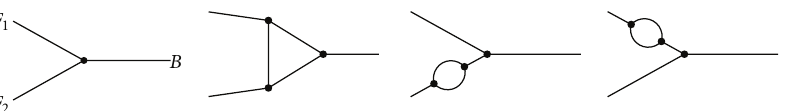
Figure 4: All topologies considered by FlavorKit to calculate the Wilson coe cients of 2-fermion-1-boson operators. All possible generic combinations of the internal fields are taken into account.